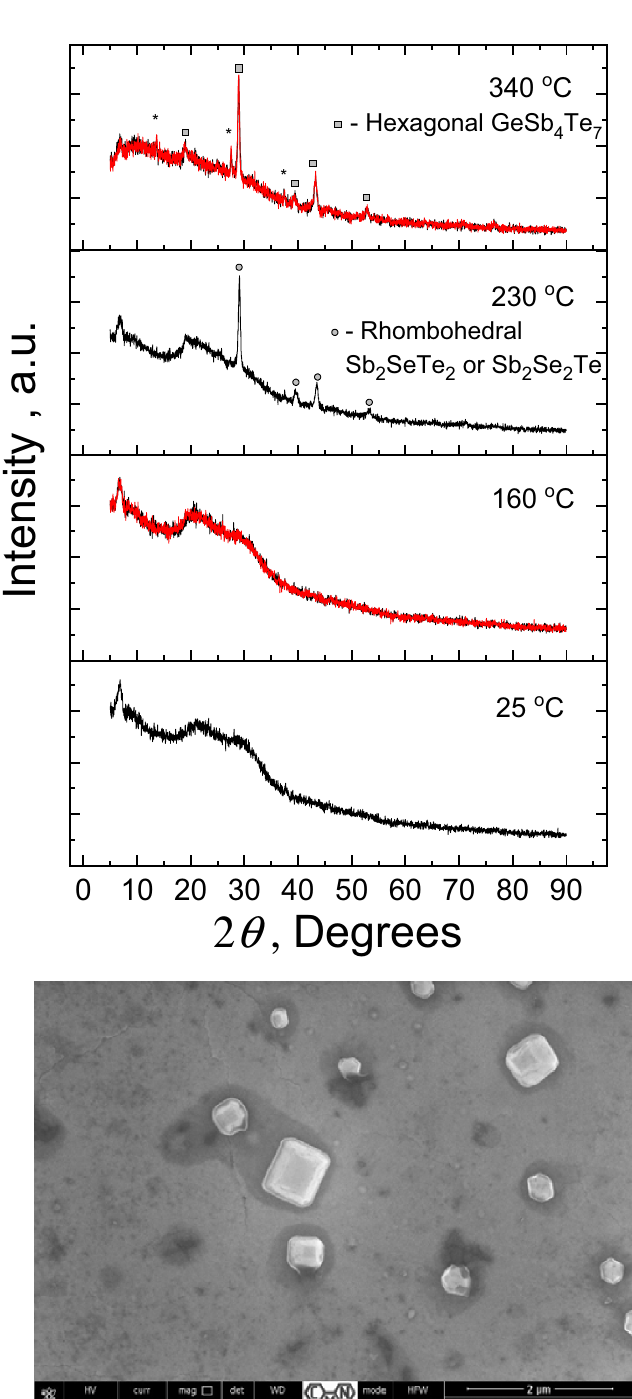
Figure 7. In situ XRD studies at different temperatures. The patterns of Ge 15 Sb 40 S 15 Se 15 Te 15 thin film deposited on microscopy slide, recorded at different target temperatures (each achieved with heating ramp of 5 K/min), are featureless until ~ 175 °C. Bottom panel shows SEM image of crystallites formed on the surface of the film after annealing at 340